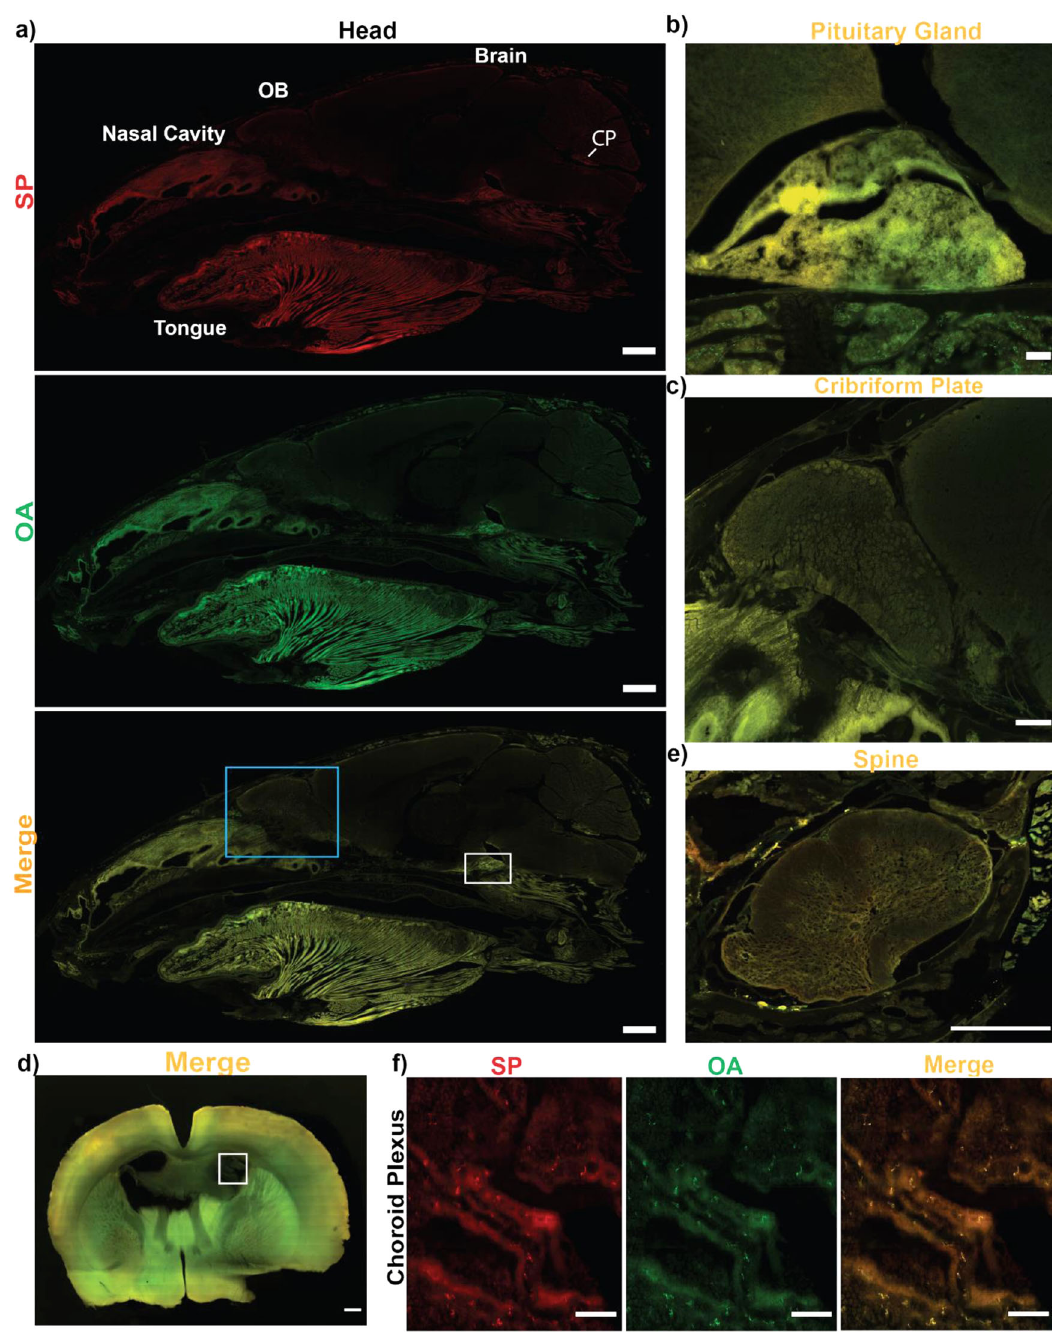
and merged images. OB (olfactory bulb). CP (choroid plexus). b Magni fi ed region (pituitary gland) of the white box in a . c Magni fi ed region (nasal/ cribriform plate) of the blue box in a . d Representative coronal sections of the merged images of SP-555 and OA-488. e Magni fi ed region (choroid plexus) of the box in d . f Merged image of the spinal cord showing the present of both tracers. Scale bars: a (1 mm); b – d (100 μ m); e (0.5 mm). Values are mean ± SEM, N = 3. Images enhanced to better show details, but not used for